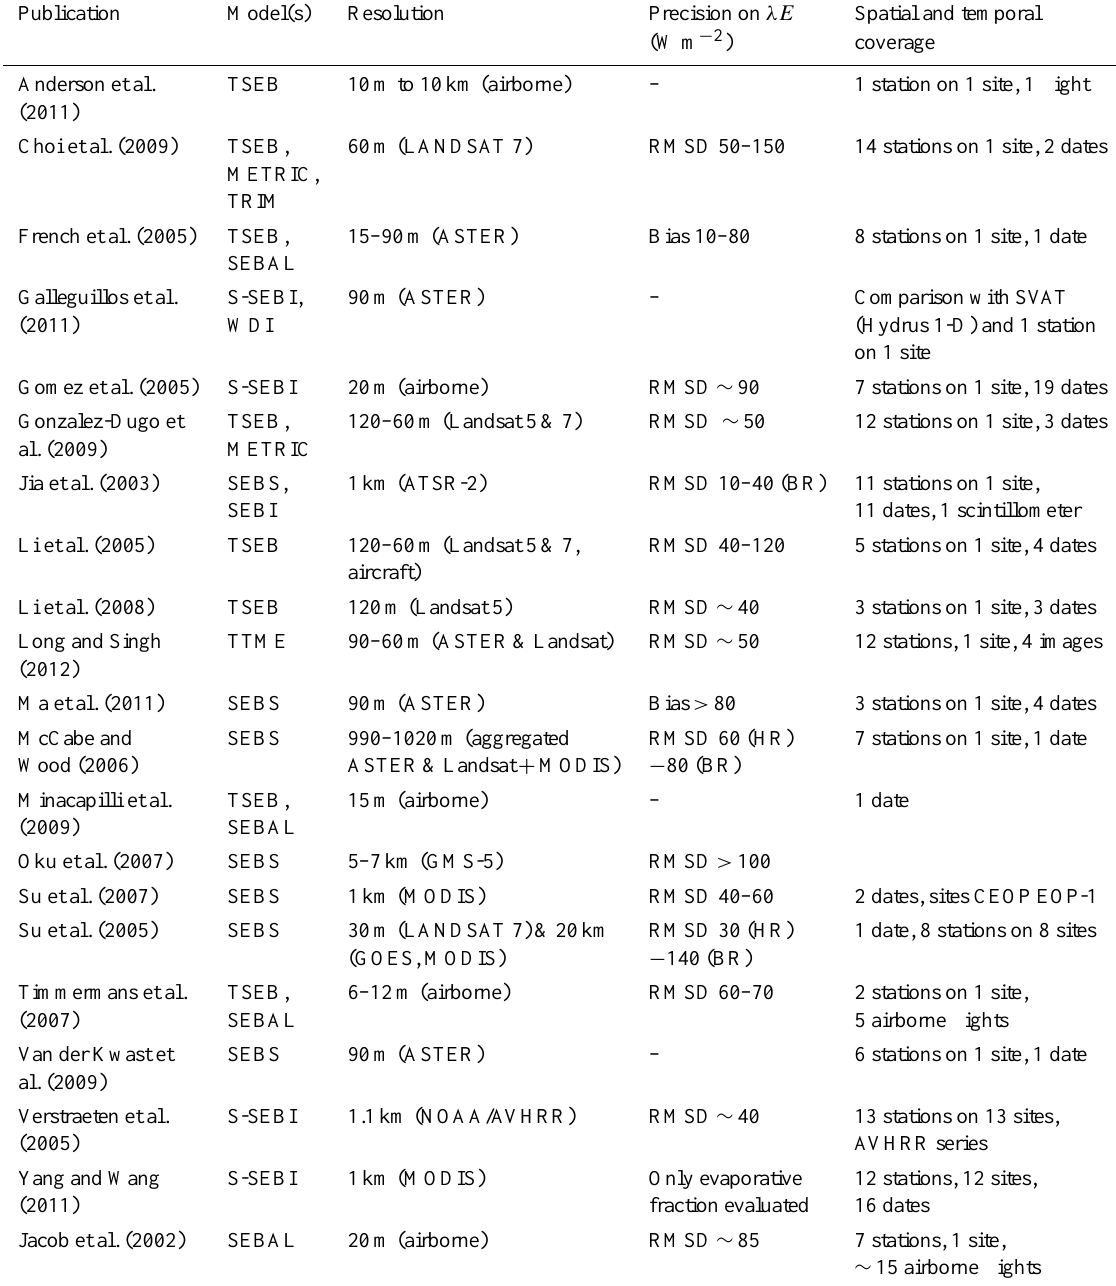
Table 1. Nonexhaustive review of validation exercises of instantaneous models. One site covers less than 30 × 30 low-resolution pixels, 1 station covers less than 10 high-resolution